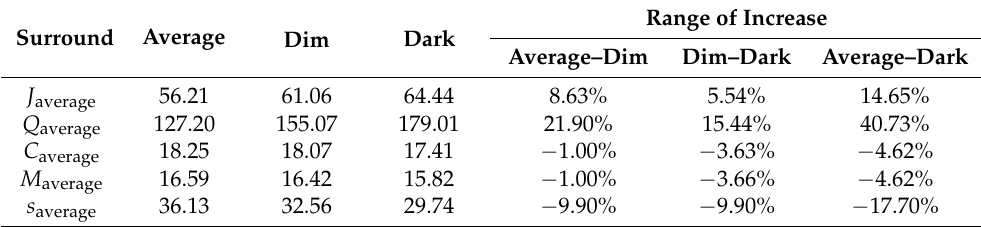
Table 3. Average values and increase rates of J (lightness), Q (brightness), C (chroma), M (colourful- ness), and s (saturation) under different surround.